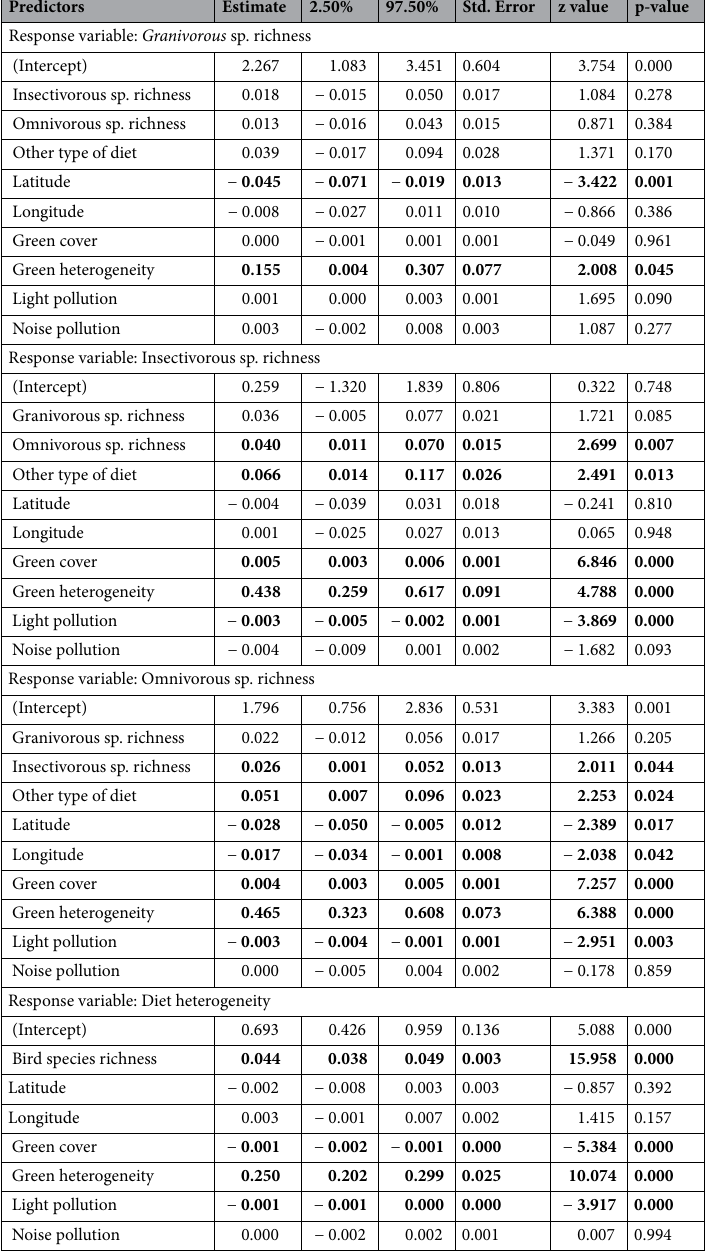
Table 2. Results of generalized linear mixed models (GLMM), accounting for variation in the richness of species for each diet category (granivorous, insectivorous, omnivorous), and diet heterogeneity of avian communities, regarding changes in green cover, green heterogeneity, latitude and longitude, level of light and noise pollution, and species richness of the other types of diet categories. The city was included as a random effect (14 groups) to account for possible consistent differences among cities. The full model is based on 1326-point counts with complete information. Std. Error standard error. Significant variables are highlighted in bold in the table. The conditional R2, which describes the proportion of variance explained by both the fixed and random factors, was 0.35 for the model on granivorous species richness, 0.42 for the model on insectivorous species richness, 0.50 for the model on omnivorous species richness, and 0.43 for the model on diet